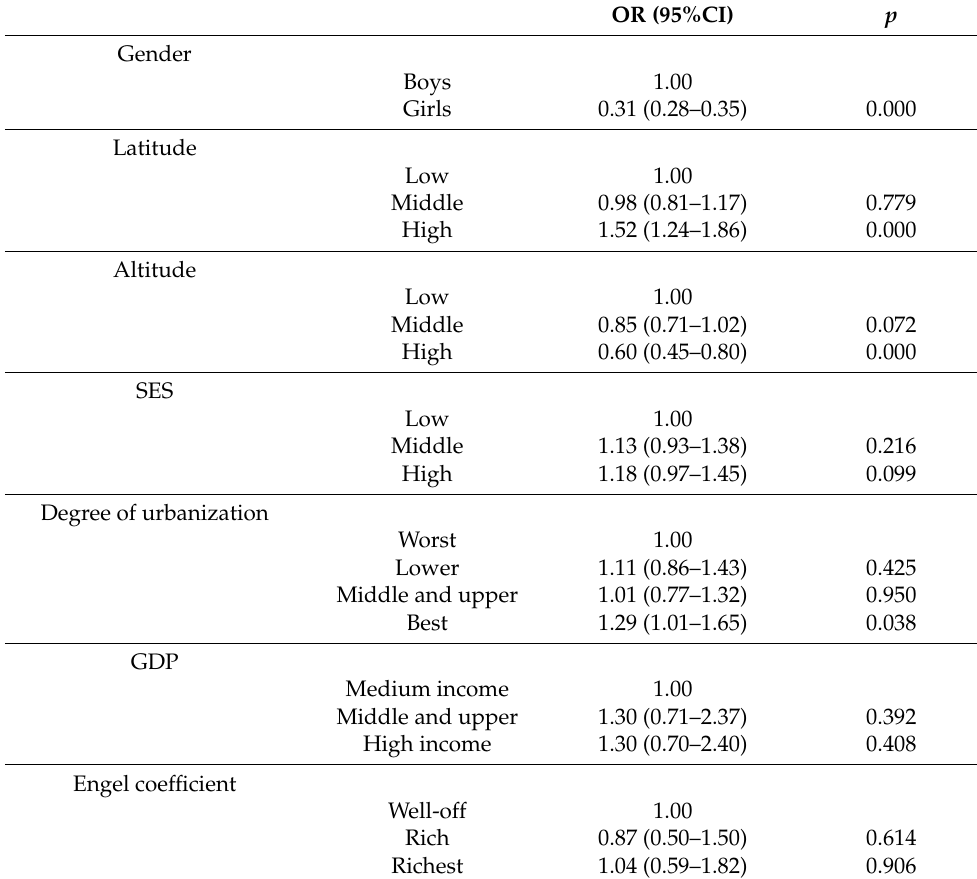
Table 7. Logistic regression of the influential factors of obesity in children and